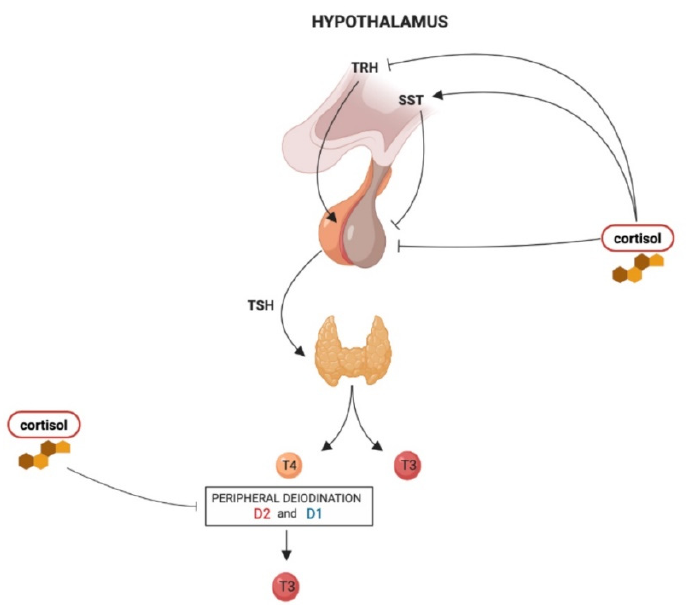
Figure 1. The influence of hypercortisolism on the hypothalamus–pituitary–thyroid (HPT) axis regulation: thyrotropin-releasing hormone (TRH) derived from the parvocellular neurons of the hypothalamic paraventricular nucleus (PVN), stimulates TSH synthesis and secretion from